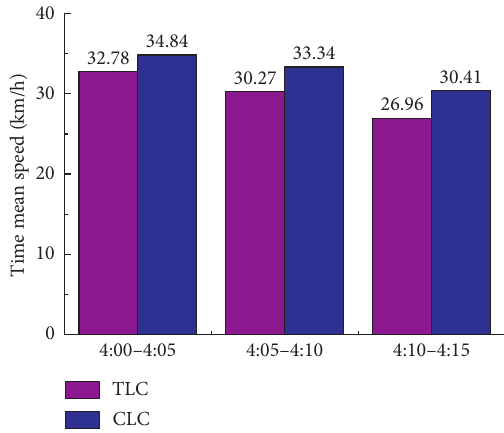
Figure 7: Time average speed